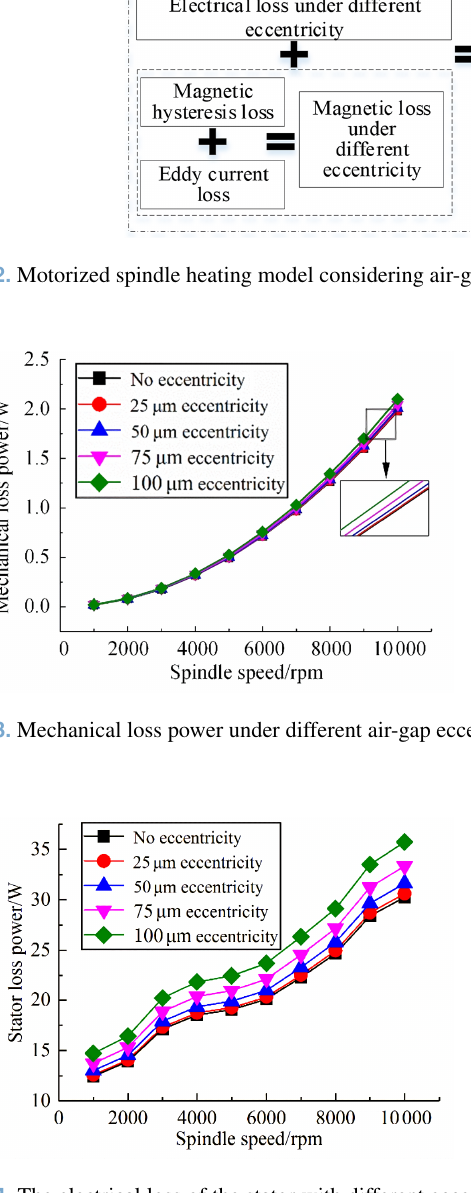
Figure 4. The electrical loss of the stator with different eccentrici- ties.